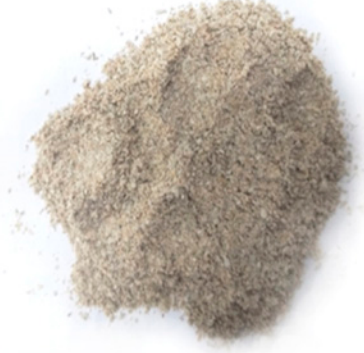
Figure 2. Bran used for the granulation process.